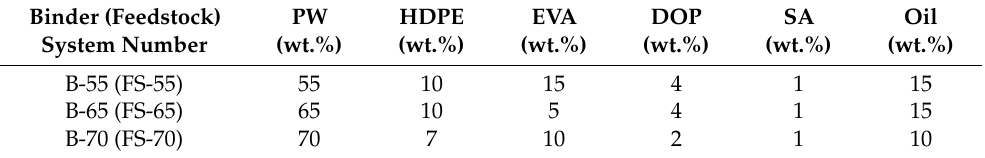
Table 2. Binder (Feedstock) systems.